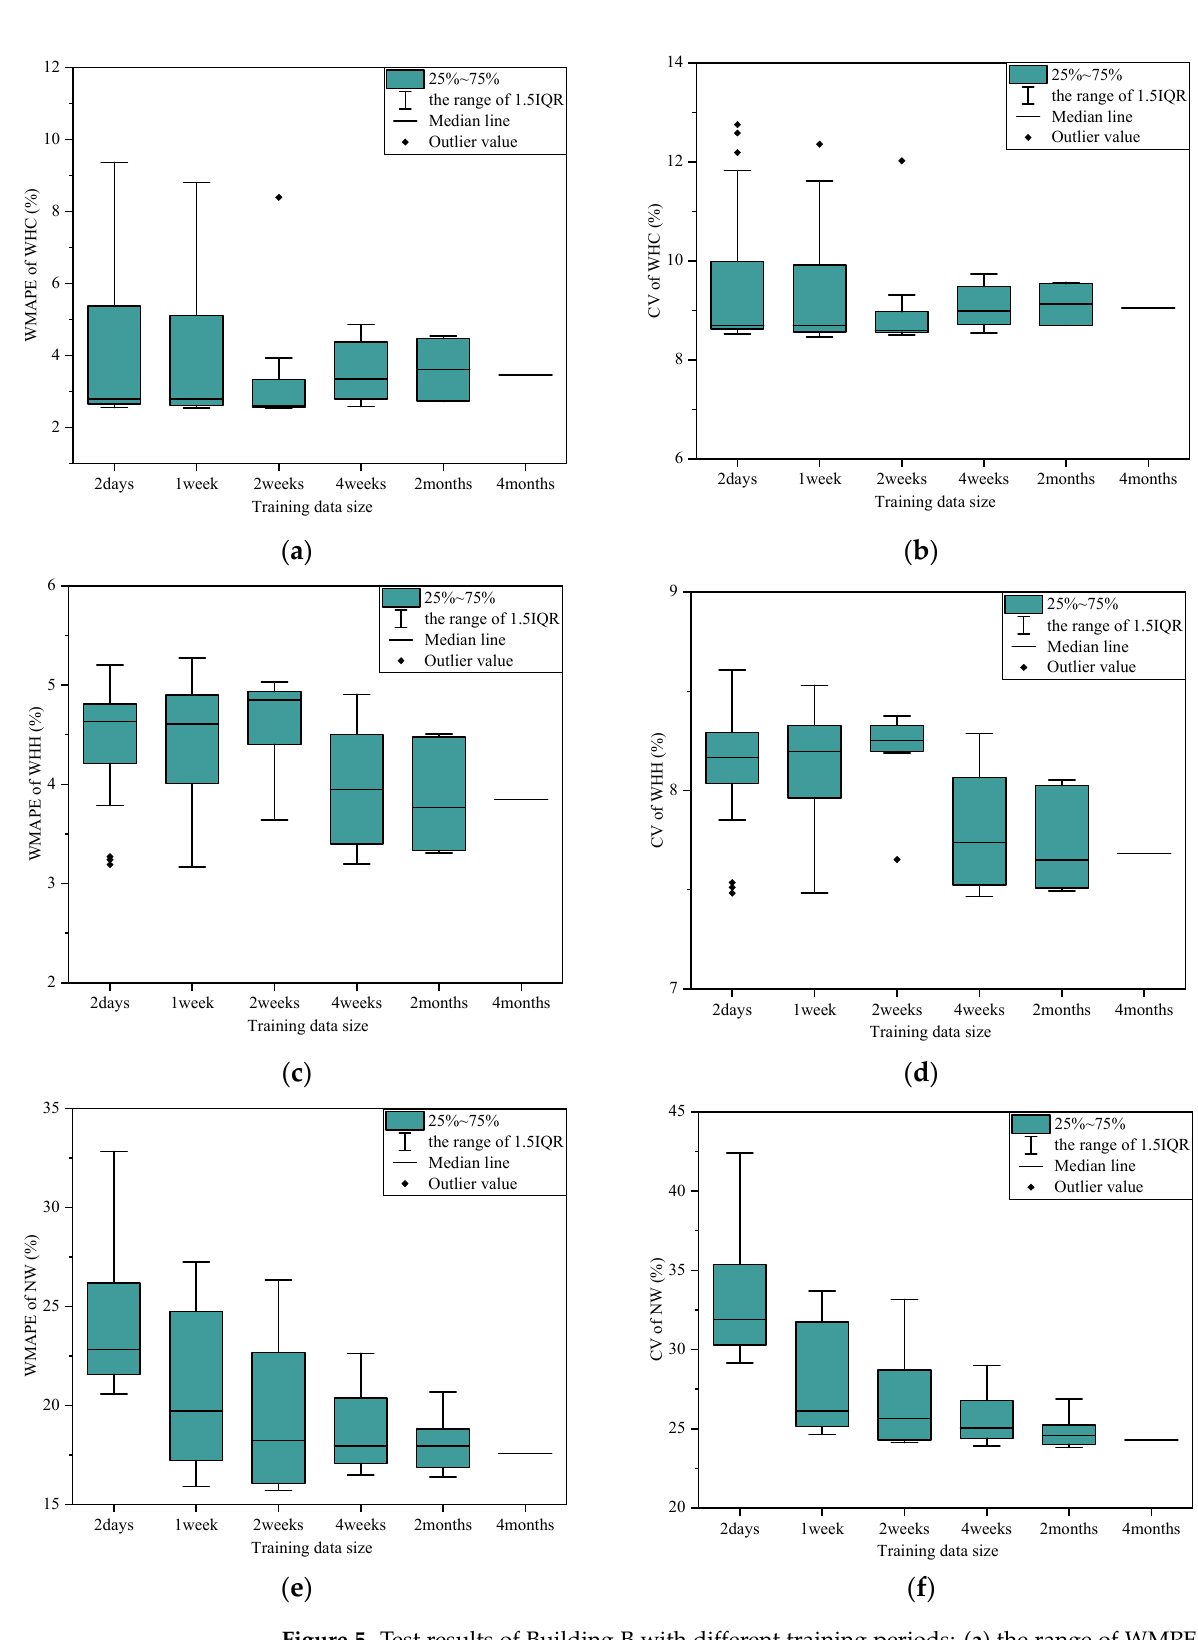
Figure 5. Test results of Building B with different training periods: ( a ) the range of WMPE varies during the WHC; ( b ) the range of CV varies during the WHC; ( c ) the range of WMPE various during the WHH; ( d ) the range of CV various during the WHH; ( e ) the range of WMPE various during the NW; and ( f ) the range of CV various during the NW.